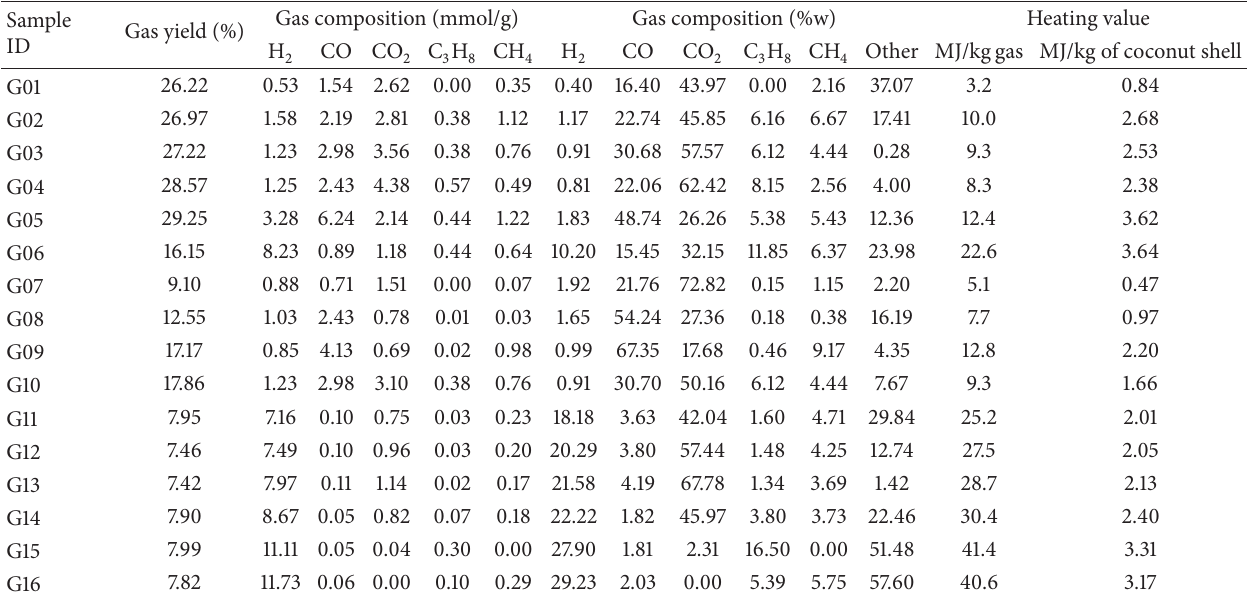
Table 3: Yields and composition of produced gas under various gasification conditions (see Table 1 for sample code).